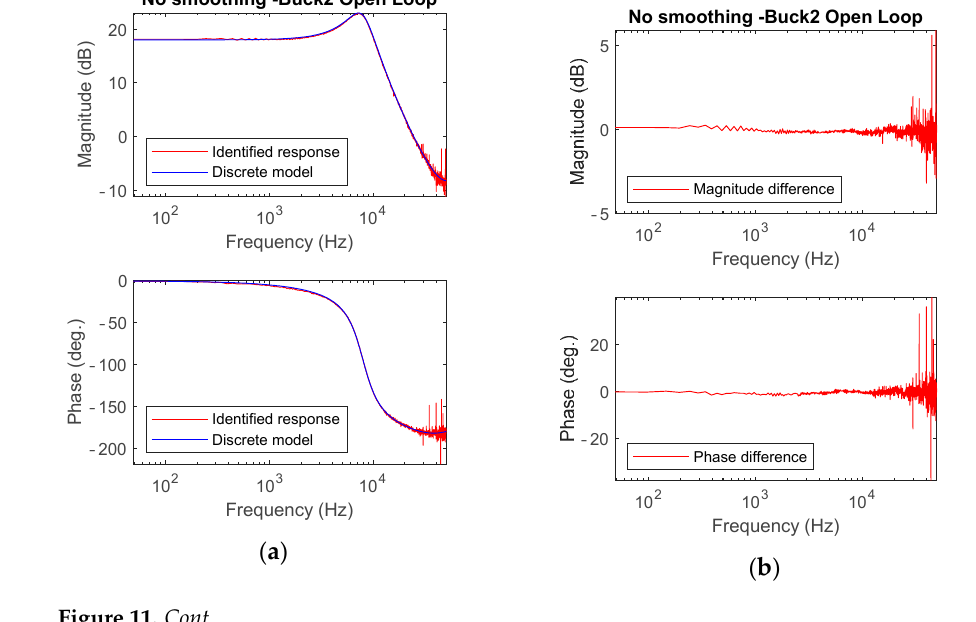
( d ) Figure 11. Buck converter open-loop results. ( a ) Bode plot without smoothing process. ( b ) Difference between discrete theoretical model and experimental measurements without smoothing process. ( c ) Bode plot with smoothing process. ( d ) Difference between model and measurement with smoothing process. Figure 11c,d show results from the same test but using the smoothing process described in Section 2. The matching between the experimental Bode plot and the theoretical model is remarkable (Figure 11c): the difference in magnitude is within ±0.25 dB and in phase within ±2 deg. (Figure 11d). Figure 12 shows the identification results of the converter Boost 1 (Table 1), for the same perturbation than in the previous case. As shown for the buck converter, the smoothing process is only applied in Figure 12c,d. Without the smoothing process, results are reasonably good up to 20 kHz approximately. When the smoothing process is applied, matching between the theoretical and the identified frequency response is remarkable: magnitude difference is within ±1.5 dB and in phase within ±7 deg. Even if these results are not so accurate as in the buck converter, they can be considered very good.